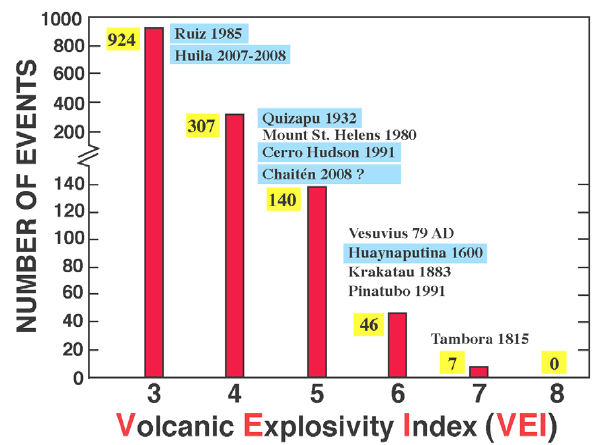
Fig. 4. Histogram of Holocene eruptions for which VEIs (see text for discussion) have been assigned; note the break in scale in the vertical axis. The number of eruptions with assigned VEIs ≤ 2 (total of 5,349 events) is not plotted because of scale limitation. Numbers highlighted in yellow give the number of eruptions of in each VEI ranking, as compiled in the Volcano Database of the Smithsonian Institution (Simkin and Siebert, 1994). A few selected historical eruptions mentioned in this paper are given to provide illustrative examples (Andean eruptions highlighted in blue).